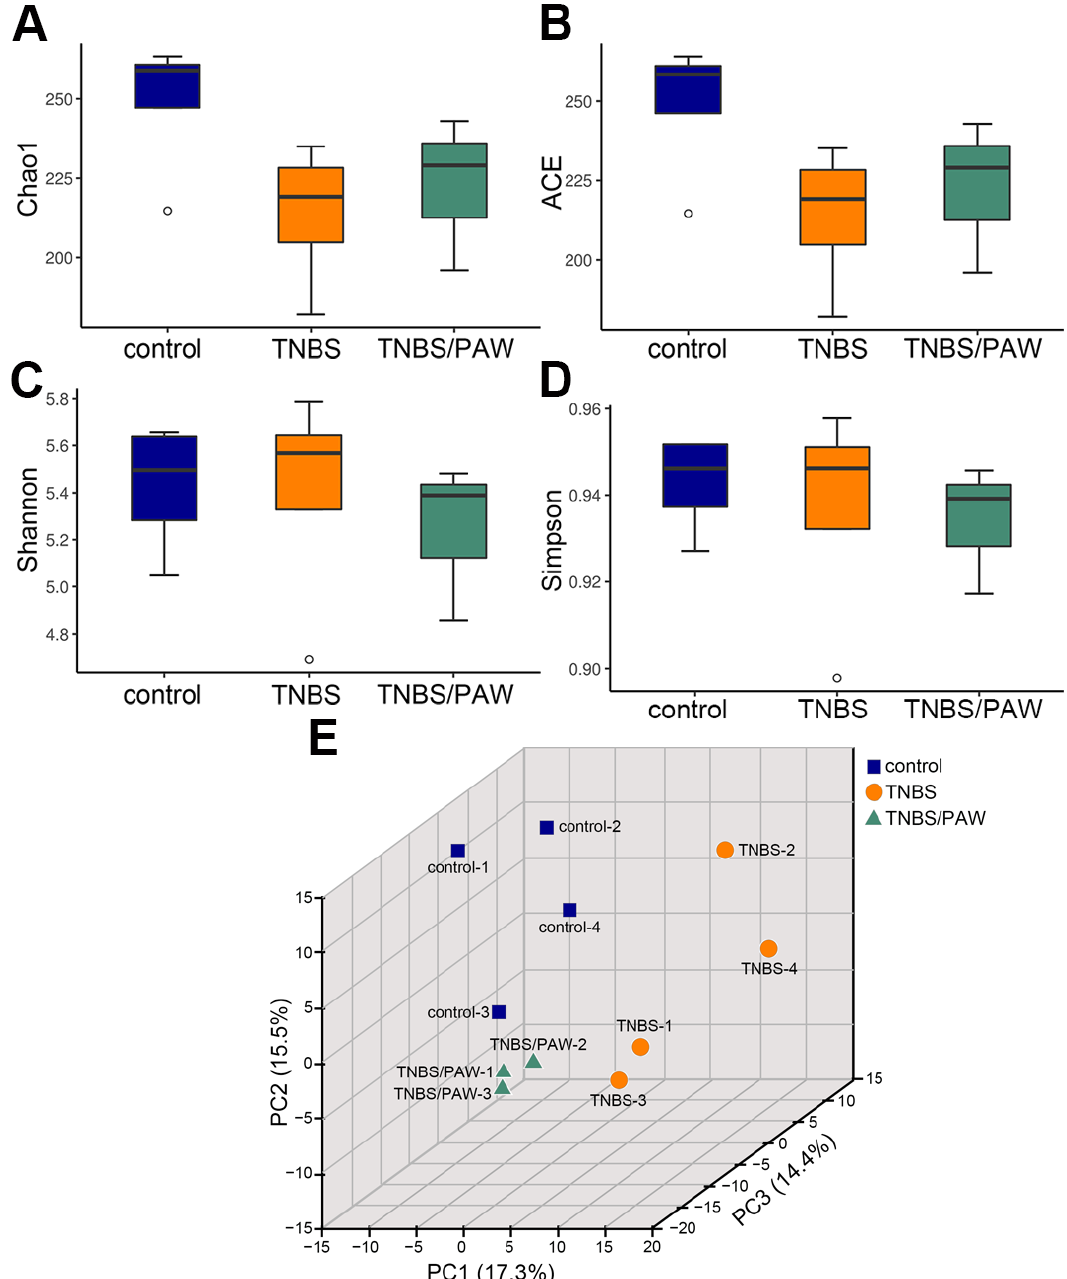
Figure 3. Changes in species richness, diversity, and similarity of gut microbiota in mice after TNBS induction and PAW consumption. ( A ) Chao1 and ( B ) ACE estimated the community richness for different treatments. ( C ) Shannon and ( D ) Simpson indicated the community diversity for different treatments. ( E ) Three-dimensional plot of PCA of microbial communities. The density plot on the axis was used to identify the similarity of distribution. The X-axis represented the first axis of the ordination while displaying the density of the sample’s ordination on the first axis, and the Y-axis was the second axis of the ordination while displaying the density of the sample’s ordination on the second axis. Blank circle, outliers. Points represented samples as the following indications: blue, control mice; orange, TNBS-treated mice; green, TNBS-treated mice with PAW consumption. TNBS, 2,4,6-trinitrobenzene sulfonic acid; PAW, plasmon-activated water; ACE, abundance-based coverage estimator; 3D-PCA, three-dimensional principal component